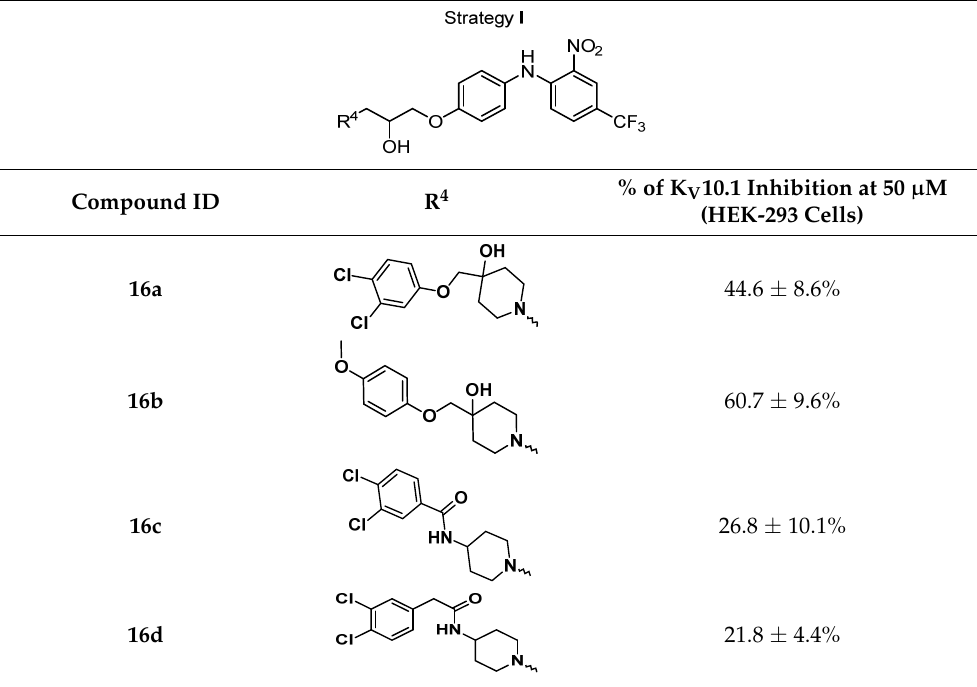
Table 2. Structures and potencies of compounds from Strategy II.